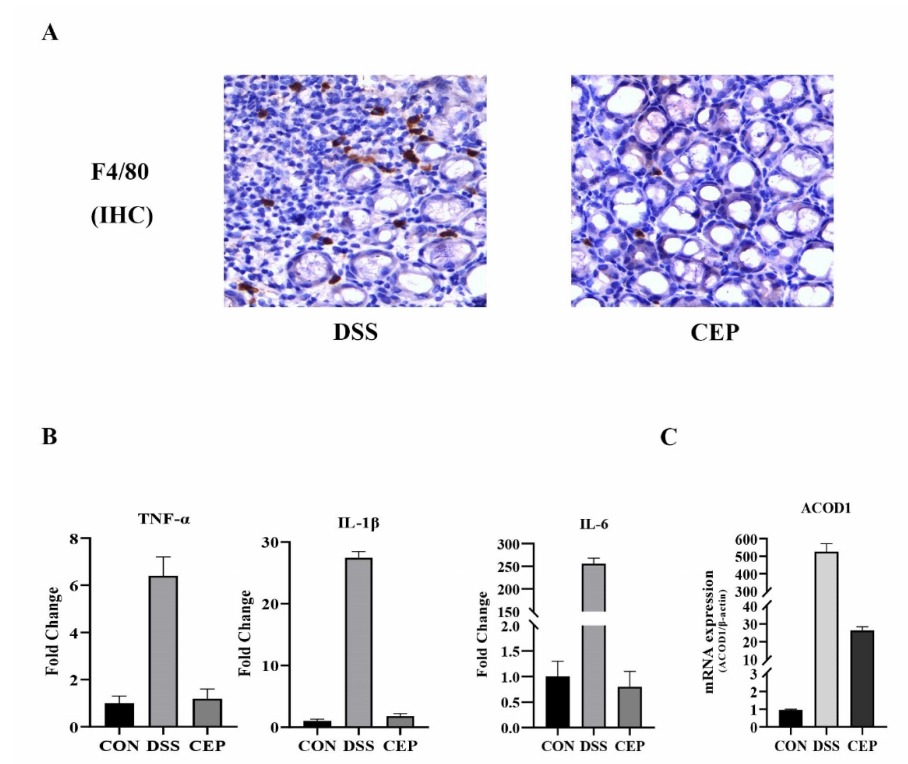
Figure 3. CEP decreases the infiltration of macrophages and ACOD1 expression in DSS-induced colitis. ( A ) Infiltrated macrophages in colon tissue were detected by immunohistochemical staining of F4/80. ( B ) Transcriptome sequencing analysis of inflammatory factors TNF- α , IL-1 β , and IL-6 transcript levels in mouse colon tissue (Both p values <0.001); ( C ) ACOD1 mRNA expression in colon tissue measured by qRT- PCR ( p values